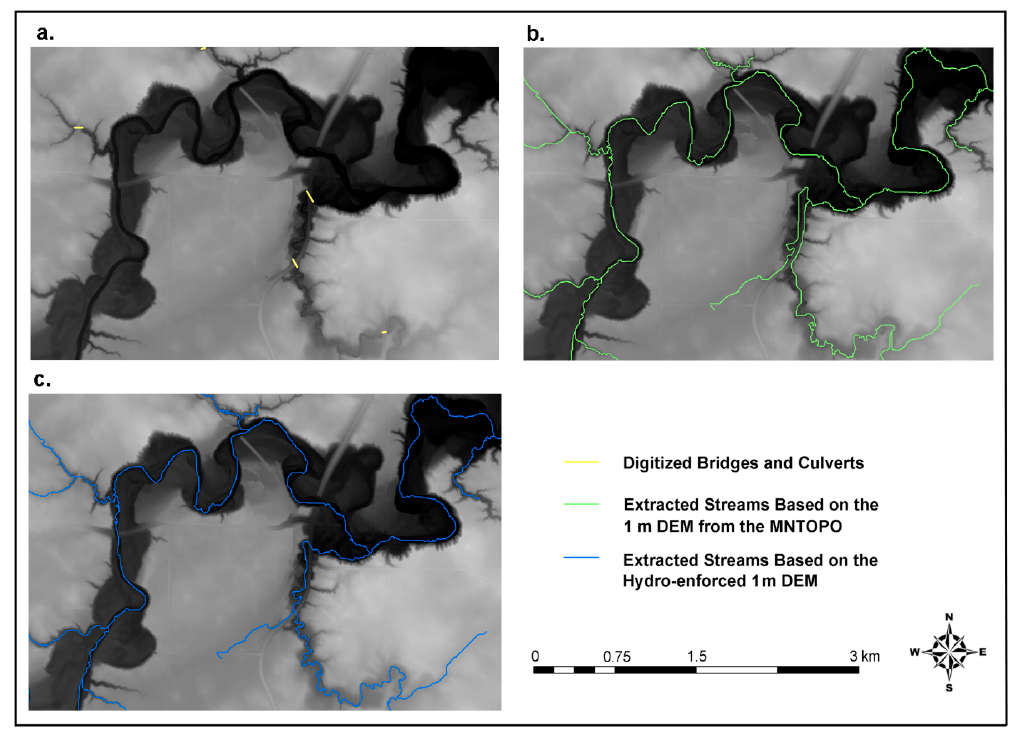
Figure 8. An example of the digitized culverts ( a ) and the extracted stream networks from the original 1-m LiDAR-based DEM ( b ), and the hydro-enforced 1-m DEM ( c ).